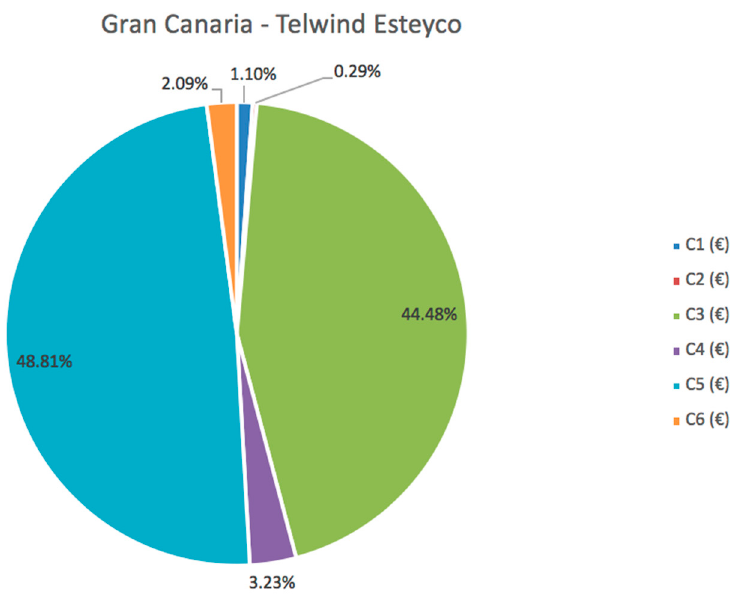
Figure 6. Main components of costs for the TELWIND ® platform .